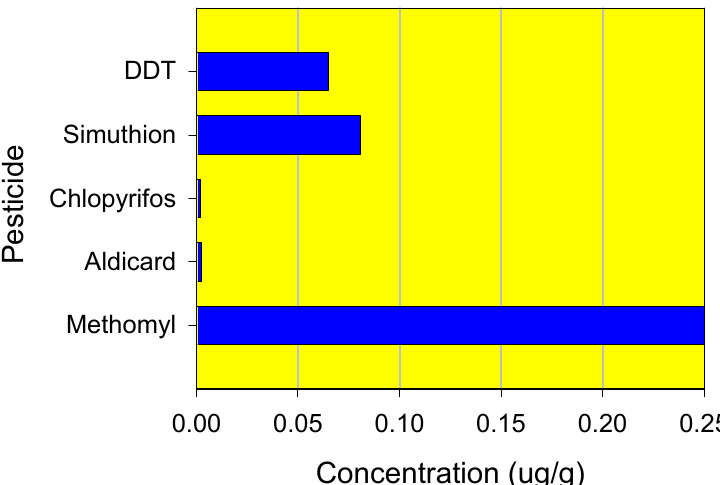
Figure 4. Maximum concentrations of pesticide residues detected in edible tissues of tilapia fish.